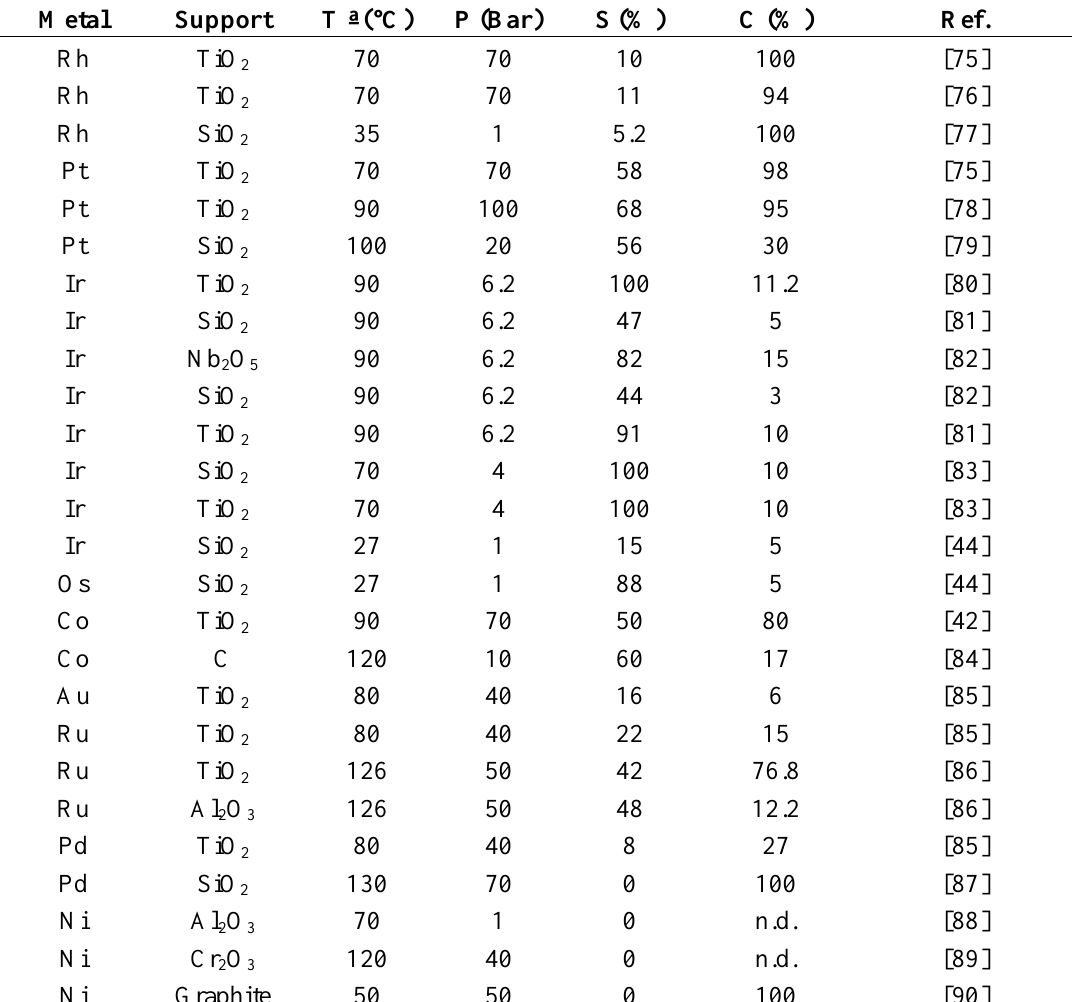
Table 1. Effect of the type of metal on the selectivity toward the un-saturated alcohol in the selective hydrogenation of